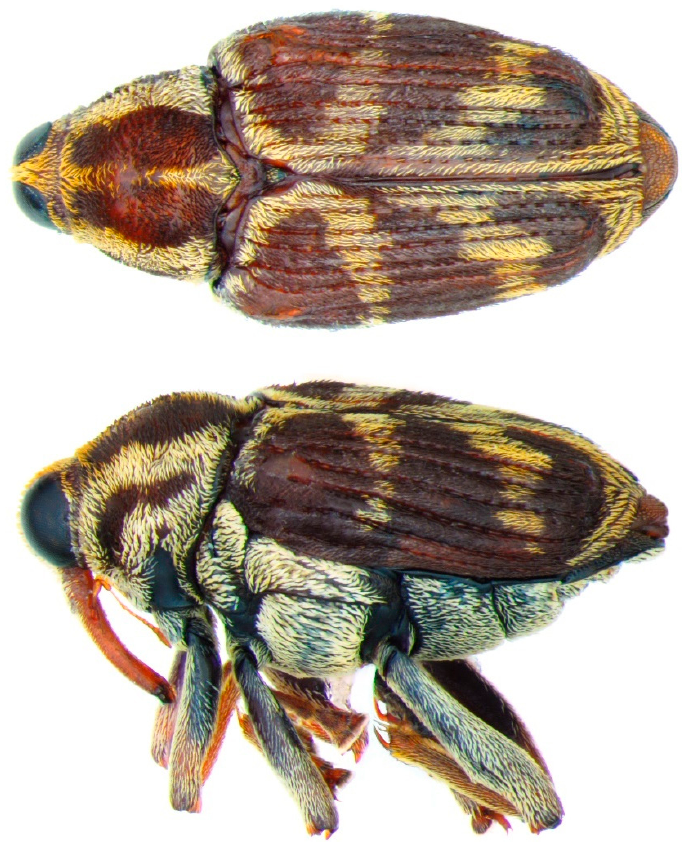
Figure 9. Philenis chiriquiensis , dorsal and lateral habitus.